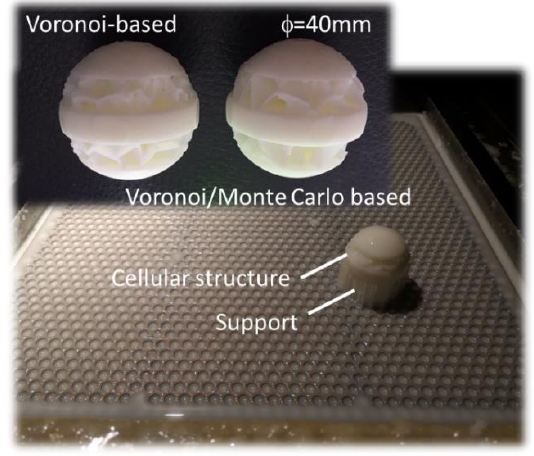
Figure 13. Rendering of the cellular structures designed using Voronoi–Monte Carlo generation scheme and manufactured using